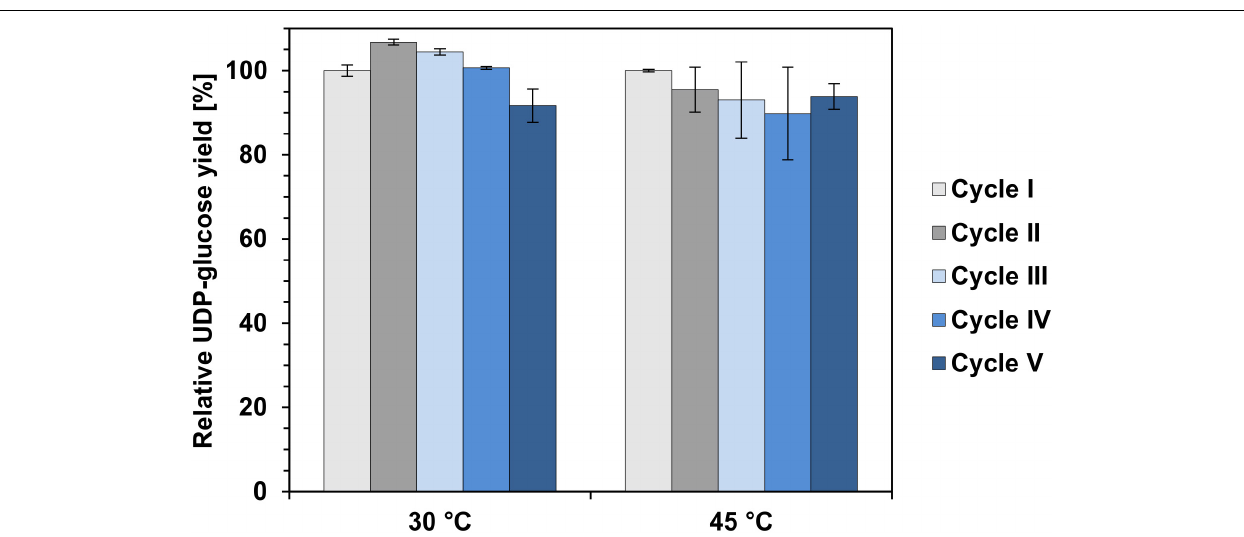
FIGURE 9 | Repeatability in batch reaction with Ta GalU immobilized on MCF. Reaction mixture contained 2 mM UTP, 2 mM G1P, 3 mM MgCl 2 , 50 mM Hepes, pH 7.0, 0.3109 µ g mL − 1 Ta GalU immobilized amino modified MCF. Reaction was carried out at 30 and 45 ◦ C in 10 mL scale. Means with standard deviations are shown from duplicate reactions. The UDP-glucose yield after first cycle was set to